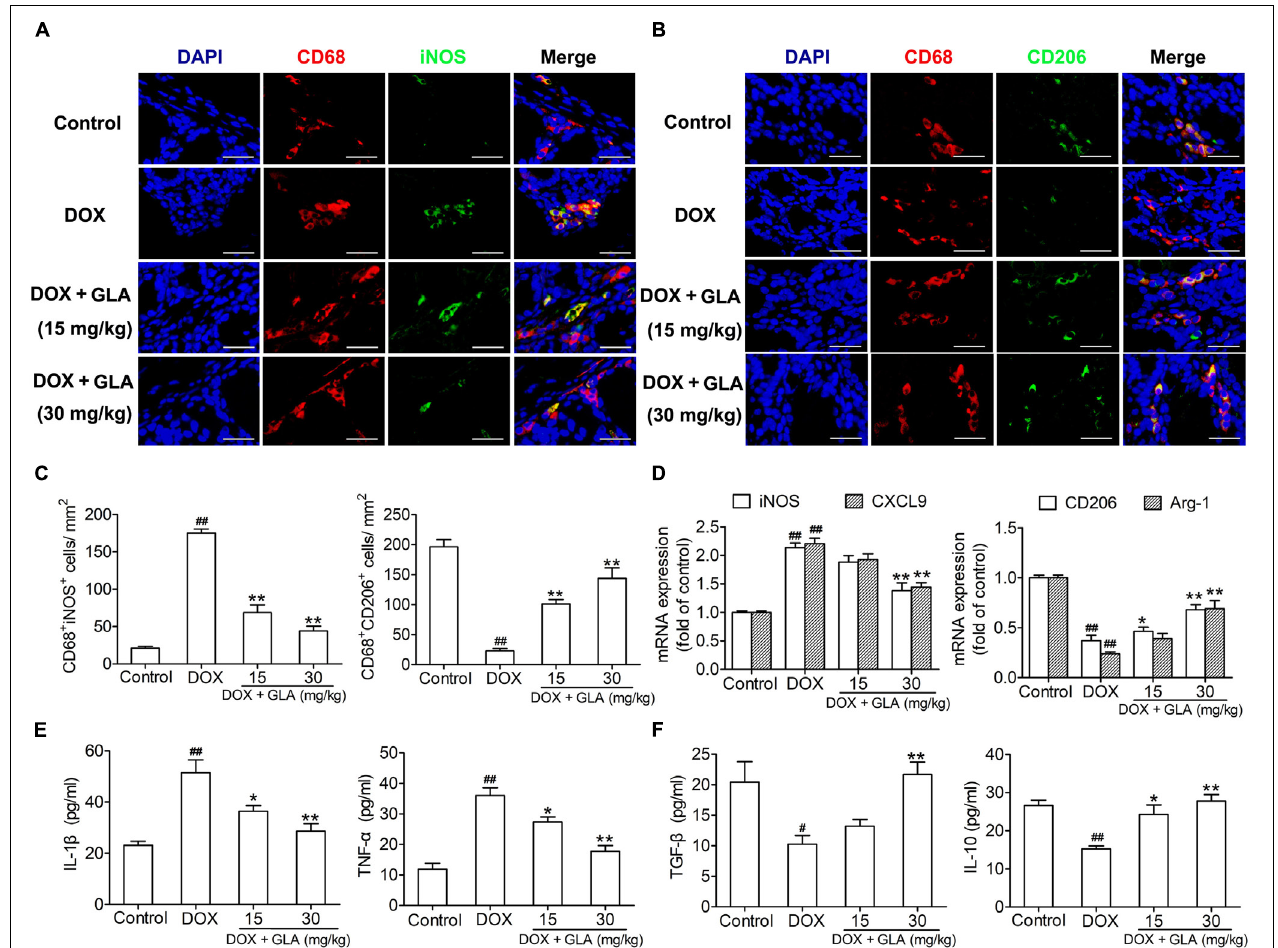
FIGURE 4 | Glabridin (GLA) switches M1-like colonic macrophages to an M2-like phenotype in the doxorubicin (DOX)-treated mice. A single dose of DOX (20 mg/kg) was intraperitoneally injected into the C57BL/6 mice to induce acute cardiotoxicity. GLA (15 and 30 mg/kg) or vehicle was intragastrically administered once daily for 12 days, starting 7 days before DOX injection. (A,B) Immunostaining analysis of CD68 + CD206 + or CD68 + iNOS + macrophages in the colon was shown ( n = 10). Scale bars, 20 µ m. (C) Corresponding quantitative analysis of CD68 + CD206 + or CD68 + iNOS + macrophages ( n = 10). (D) Relative mRNA levels of M1 marker (iNOS and CXCL-9) and M2 markers (CD206 and arginase-1) in the colonic macrophages were measured by qPCR. (E,F) M1 cytokines (TNF- α and CCL2) and M2 cytokines (TGF- β and IL-10) in the culture supernatants of colonic macrophages were determined by ELISA ( n = 10). The values are presented as the mean ± SEM. # P < 0.05, ## P < 0.01 vs. control, ∗ P < 0.05, ∗∗ P < 0.01 vs.